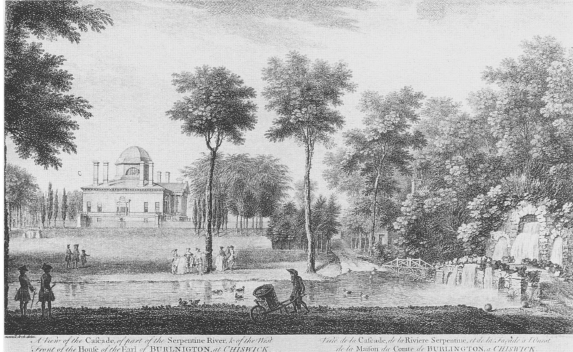
Figure 6. Chiswick House Grounds; the cascade and surroundings, conceived by William Kent in I733 and drawn by Donowell and engraved by Woollett in 1752. (Photo from David Jacques)